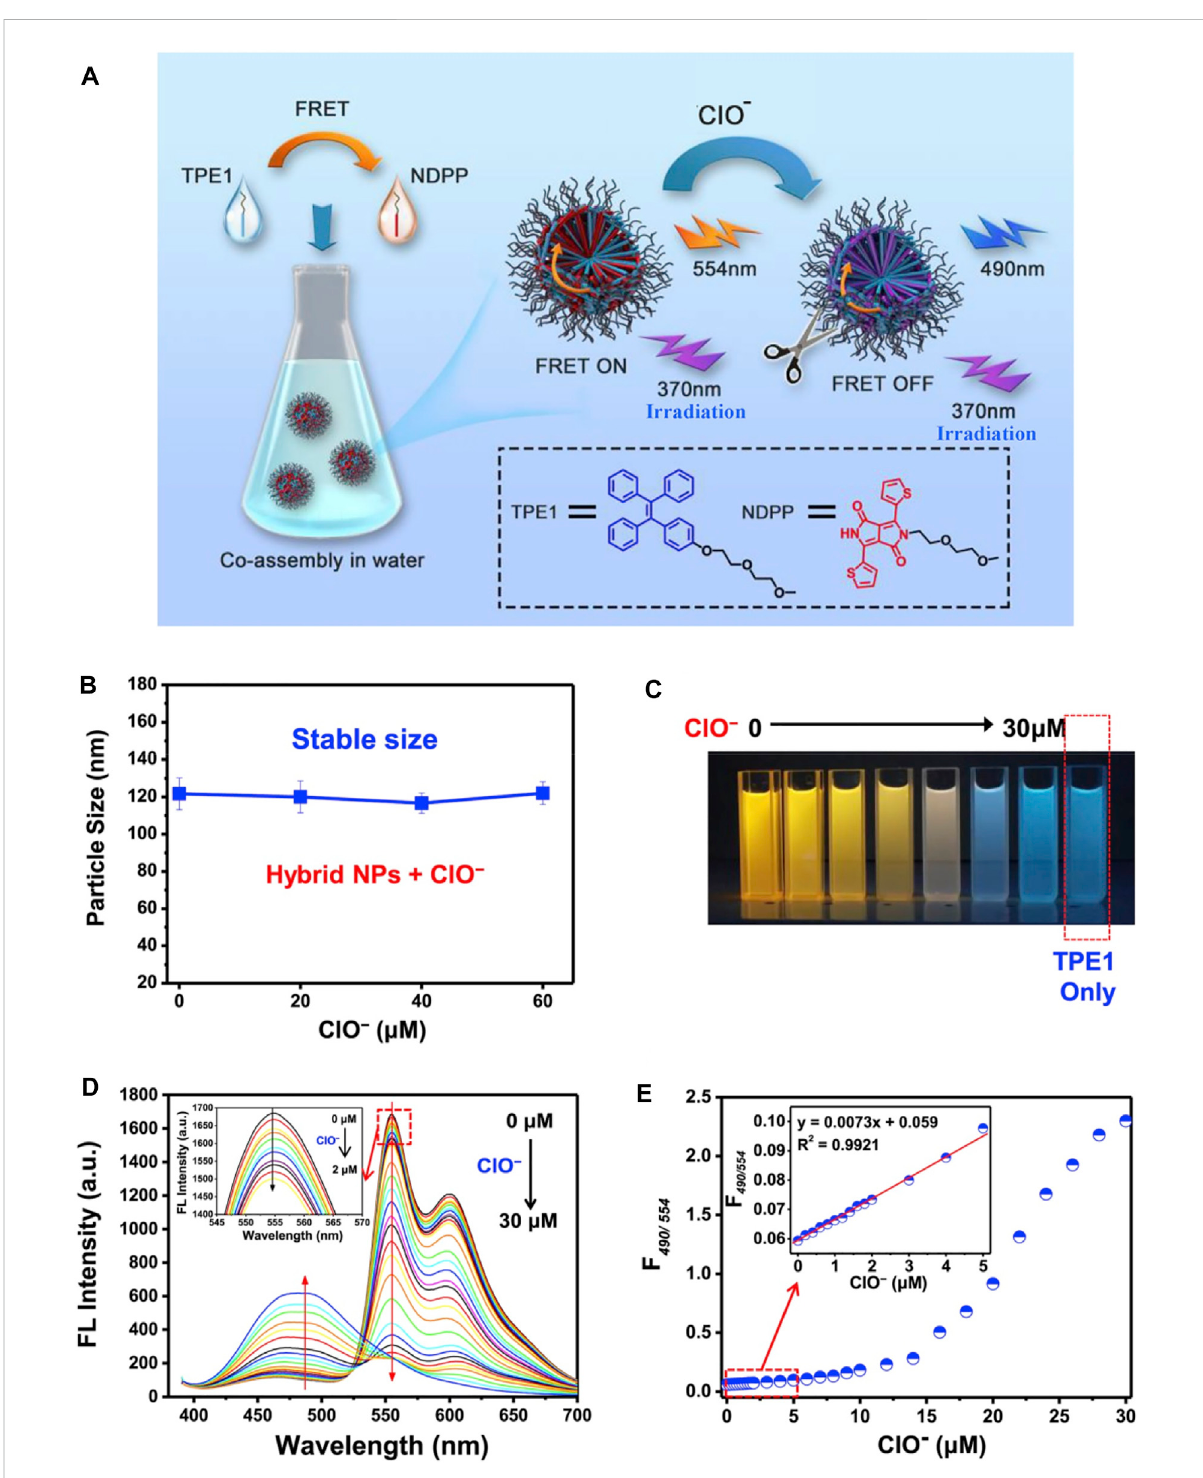
FIGURE 9 (A) ConstructionofamicellarFRETnanoprobecomposedofaTPE/NDPPpairandtheeffectofClO-; (B) changesintheDLSsizeofTPE1-NDPP NPsupontheaddition ofincreasing amountsofClO − inwater; (C) photons ofasolutionwith TPE1-NDPPNPsanddifferentamounts ofClO − (0,4, 8, 16, 20, 25, and 30 μ M) under a UV lamp; (D) changes in the fl uorescence spectra of the TPE1-NDPP NPs upon the addition of increasing amounts of ClO − (1 – 30 μ M) in water. Inset: the addition of a low concentration of ClO − (0, 0.2, 0.4, 0.6, 0.8, 1.0, 1.2, 1.4, 1.6, 1.8, 2.0 μ M); and (E) fl uorescence intensity ratio (F490/554) changes of TPE1-NDPP NPs upon exposure to ClO − (Nie et al.,